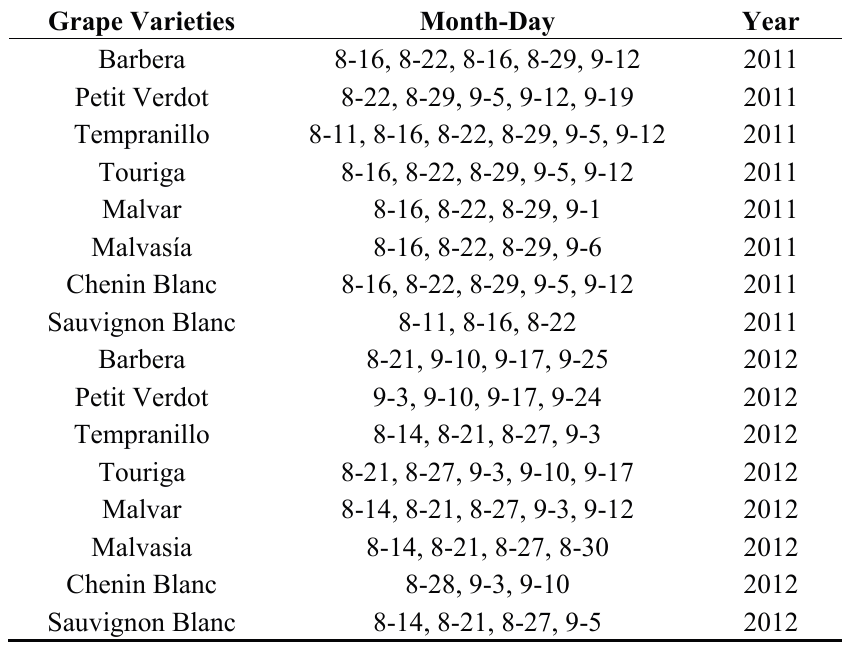
Table 1. Grape collection date of the different varieties used for the physico-chemical parameter